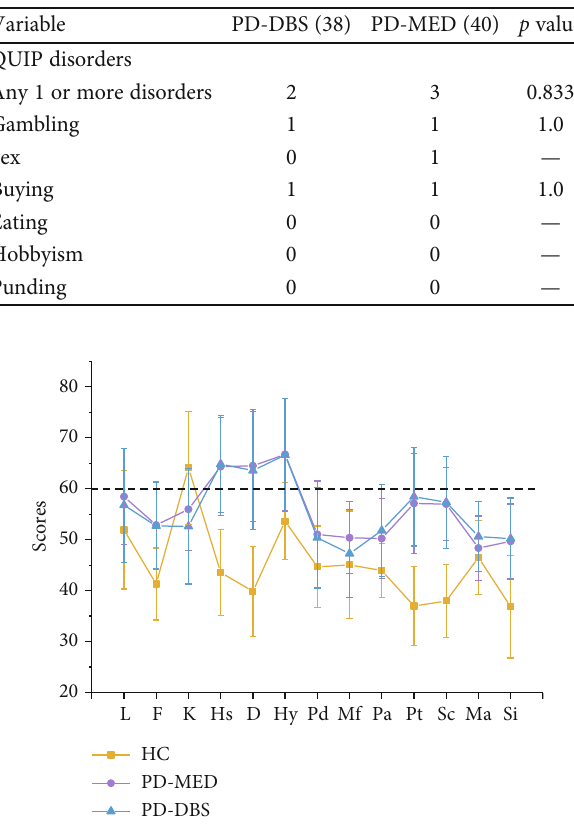
Table 2: Comparison between patients with and without ICD behaviors.